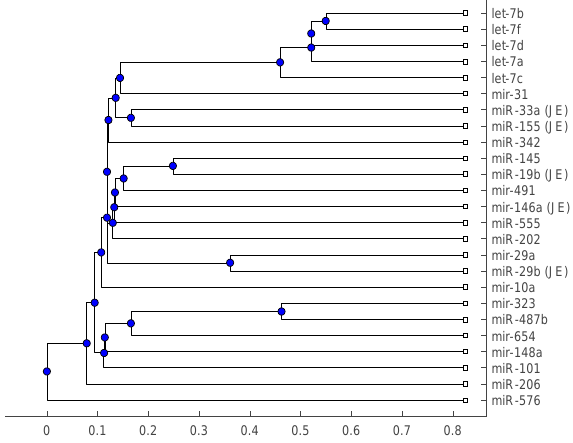
Figure 1. The phylogenetic tree of miRNAs based on the Juke–Cantor distance and single linkage function.